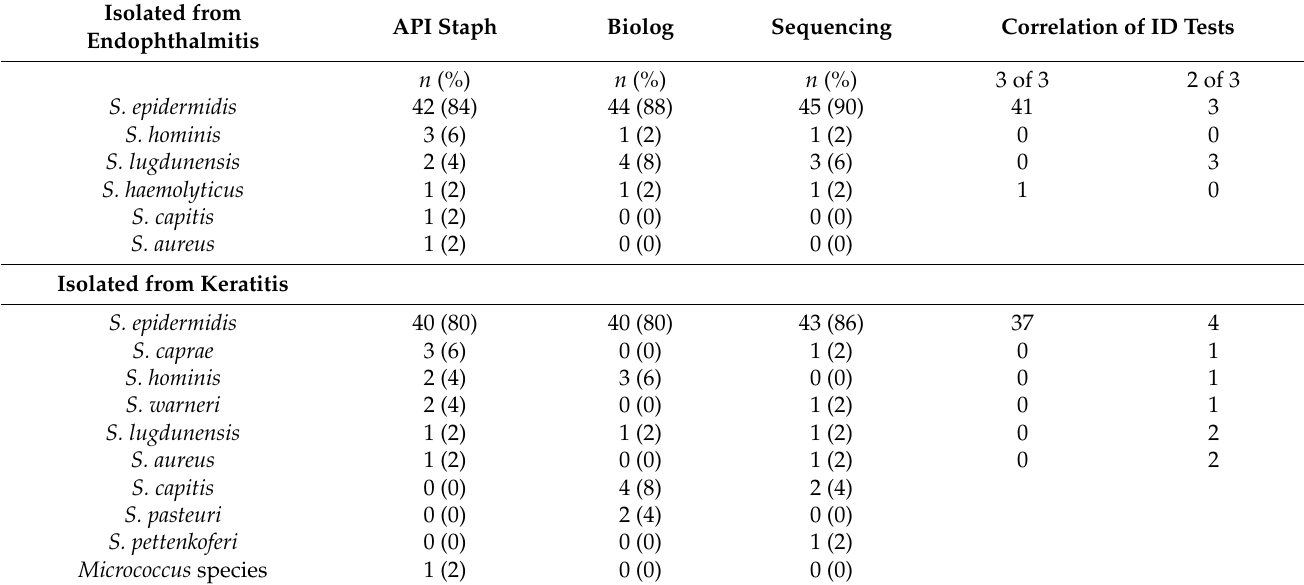
Table 1. Identification of coagulase-negative staphylococci (S.) from endophthalmitis, keratitis, and conjunctivitis/blepharitis using API Staph, Biolog, and DNA